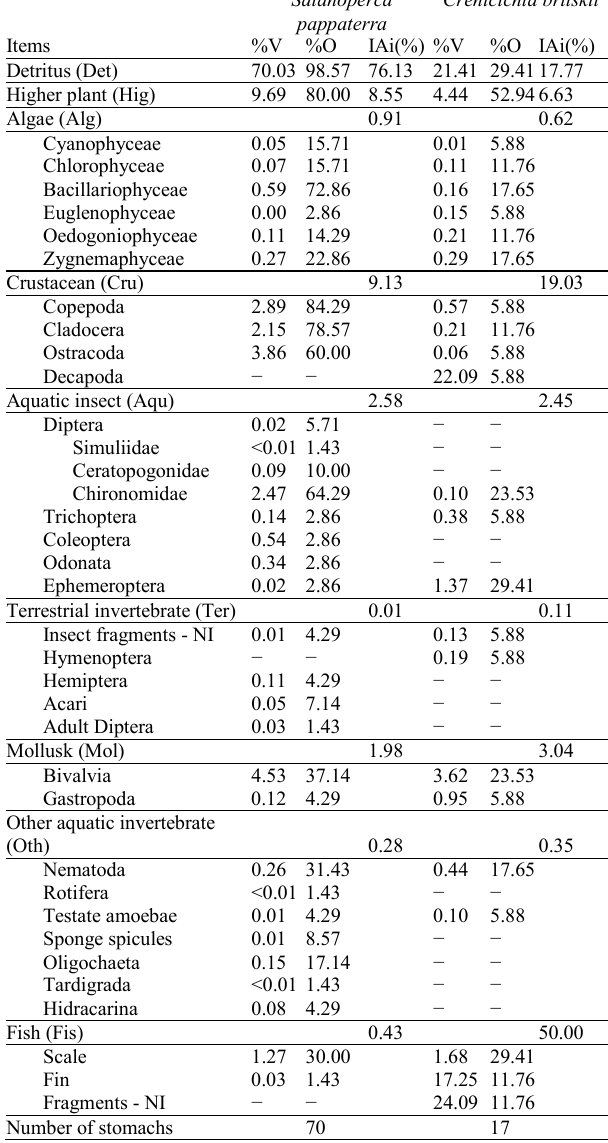
Table 3. Diet composition and alimentary index of Satanoperca pappaterra and Crenicichla britskii in the Upper Paraná River floodplain (%V = percentage of volume; %O = percentage of occurrence and IAi = alimentary index; NI =